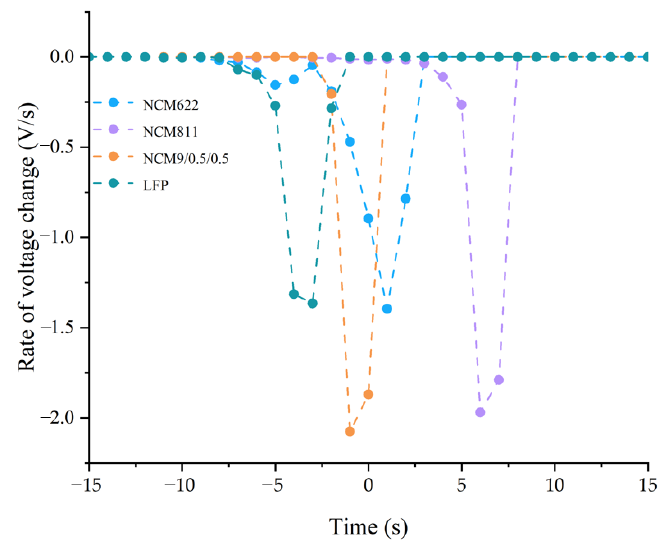
Figure 4. Voltage change rate.